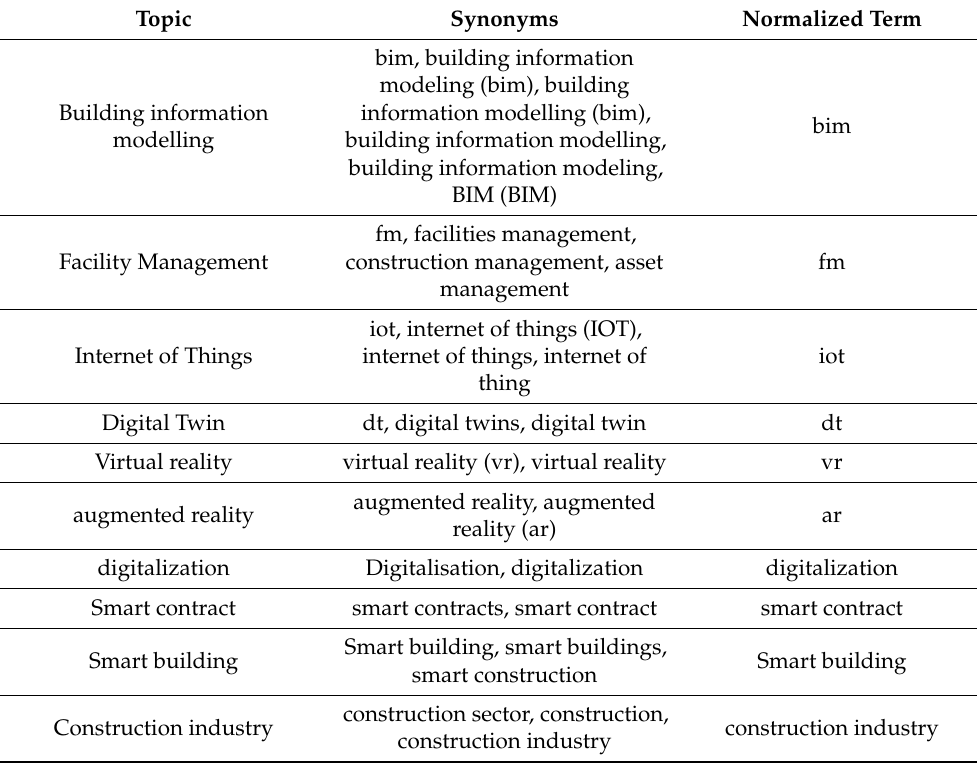
Table 2. Data cleaning: list of synonyms.